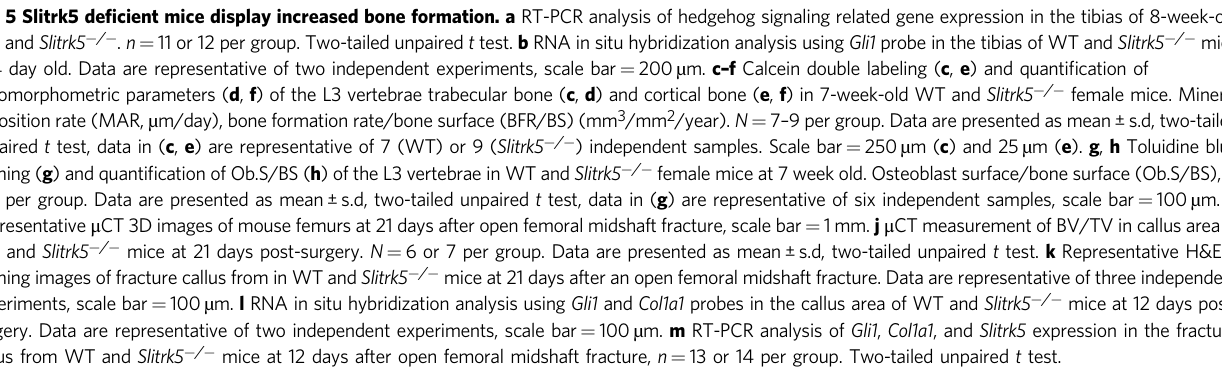
Fig. 5 Slitrk5 de fi cient mice display increased bone formation. a RT-PCR analysis of hedgehog signaling related gene expression in the tibias of 8-week-old WT and Slitrk5 − / − . n = 11 or 12 per group. Two-tailed unpaired t test. b RNA in situ hybridization analysis using Gli1 probe in the tibias of WT and Slitrk5 − / − mice at 4 day old. Data are representative of two independent experiments, scale bar = 200 µ m. c – f Calcein double labeling ( c , e ) and quanti fi cation of histomorphometric parameters ( d , f ) of the L3 vertebrae trabecular bone ( c , d ) and cortical bone ( e , f ) in 7-week-old WT and Slitrk5 − / − female mice. Mineral apposition rate (MAR, µ m/day), bone formation rate/bone surface (BFR/BS) (mm 3 /mm 2 /year). N = 7 – 9 per group. Data are presented as mean±s.d, two-tailed unpaired t test, data in ( c , e ) are representative of 7 (WT) or 9 ( Slitrk5 − / − ) independent samples. Scale bar = 250 µ m ( c ) and 25 µ m ( e ). g , h Toluidine blue staining ( g ) and quanti fi cation of Ob.S/BS ( h ) of the L3 vertebrae in WT and Slitrk5 − / − female mice at 7 week old. Osteoblast surface/bone surface (Ob.S/BS), n = 6 per group. Data are presented as mean±s.d, two-tailed unpaired t test, data in ( g ) are representative of six independent samples, scale bar = 100 µ m. i WT and Slitrk5 − / − mice at 21 days post-surgery. N = 6 or 7 per group. Data are presented as mean±s.d, two-tailed unpaired t test. k Representative